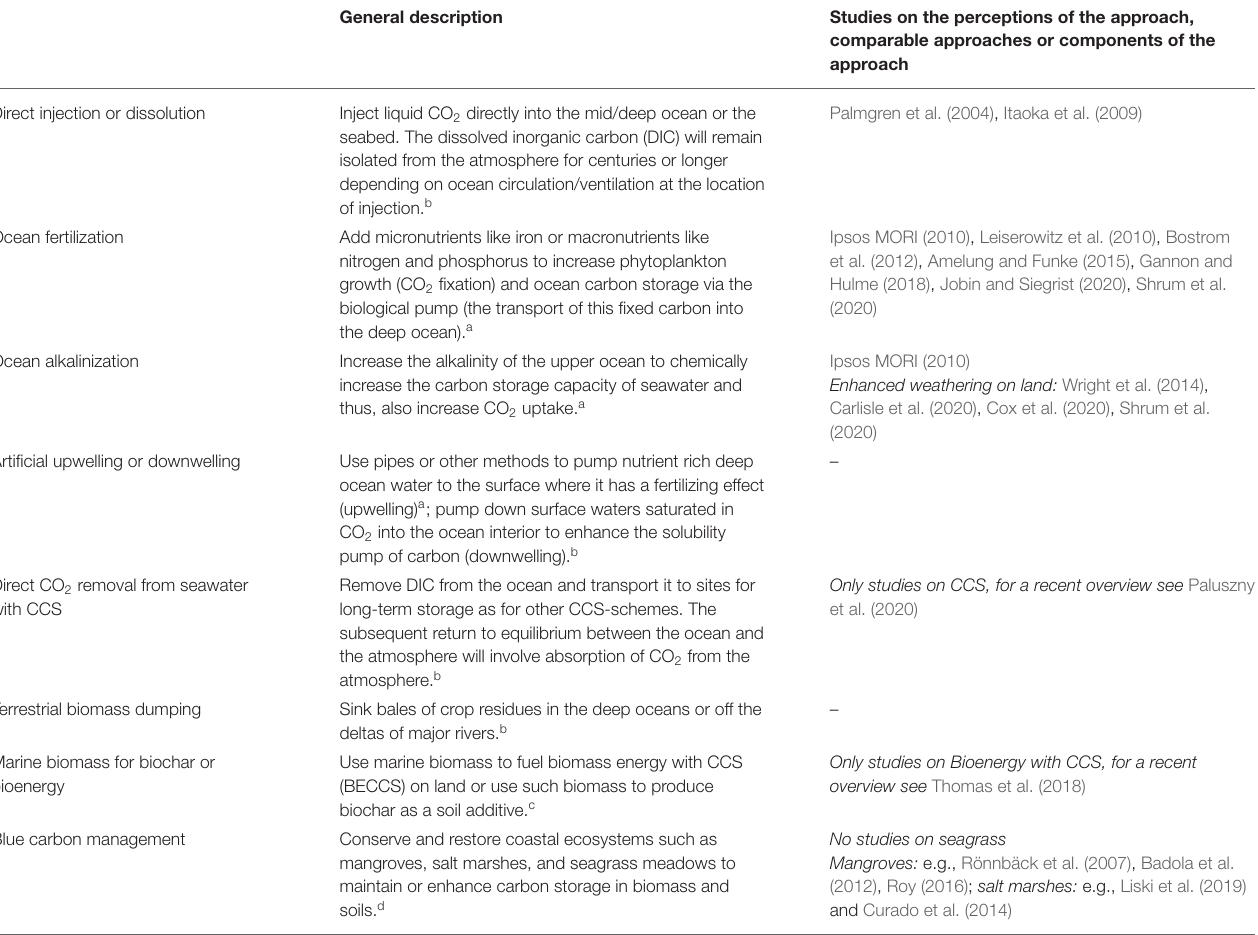
TABLE 1 | Overview of public perceptions research on ocean-based CDR approaches and other relevant studies. General